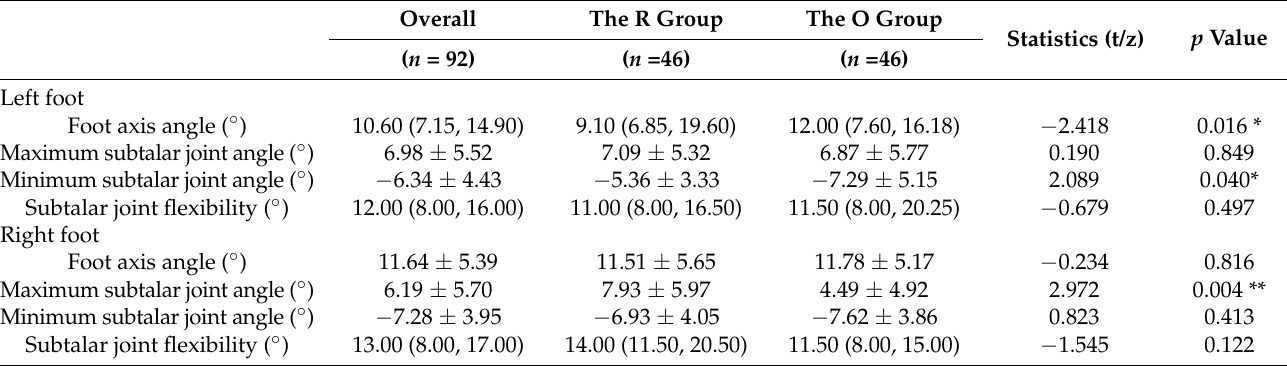
Table 4. Foot axis parameters of the older women in the O and R